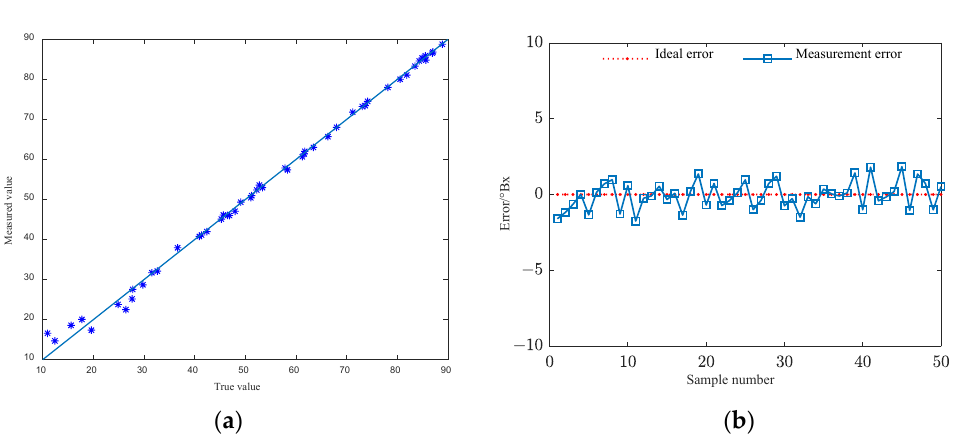
Figure 10. Measurement results of syrup brix based on PSO–SVR in the independent test set. ( a ) Measurement results of brix; ( b ) Measurement errors of brix.